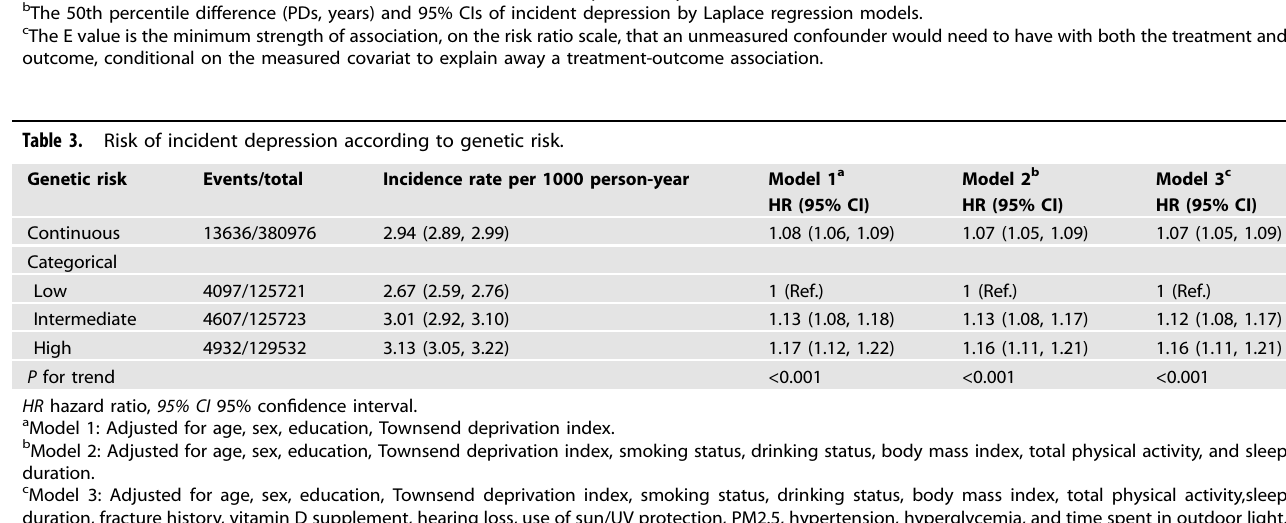
b Model 2: Adjusted for age, sex, education, Townsend deprivation index, smoking status, drinking status, body mass index, total physical activity, and sleep duration. c Model 3: Adjusted for age, sex, education, Townsend deprivation index, smoking status, drinking status, body mass index, total physical activity,sleep duration, fracture history, vitamin D supplement, hearing loss, use of sun/UV protection, PM2.5, hypertension, hyperglycemia, and time spent in outdoor